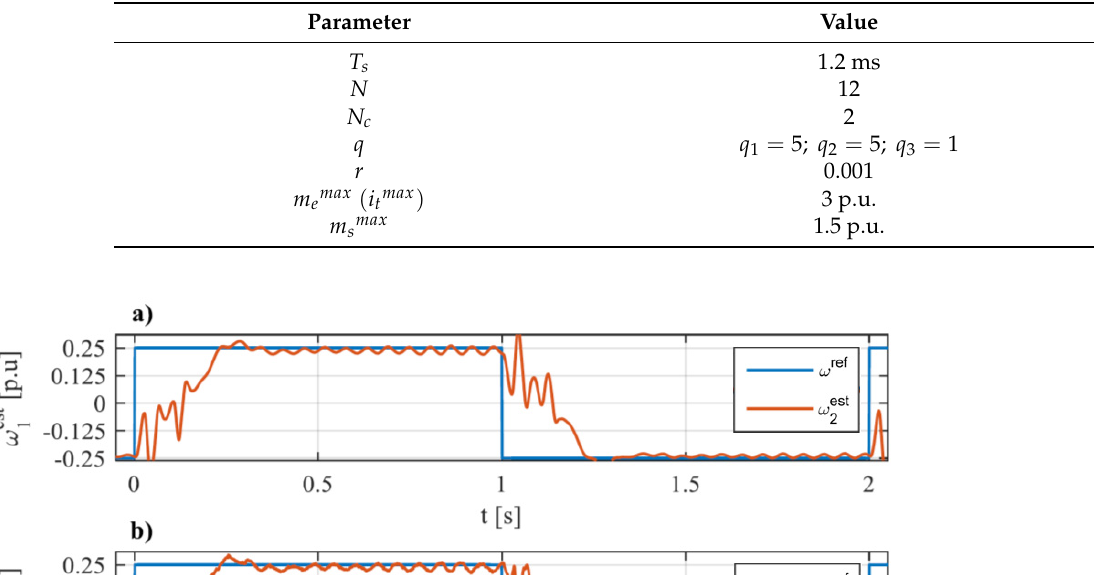
Table 2. Parameters of the predictive controller.